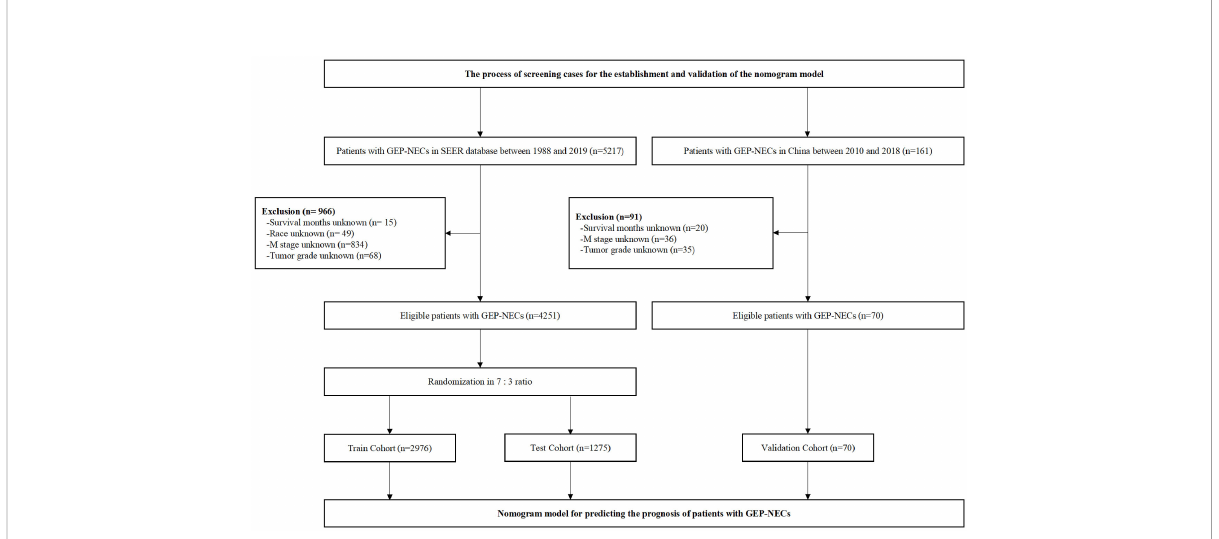
FIGURE 1 Flow chart of data fi ltering. SEER, Surveillance, Epidemiology, and End Results; GEP-NECs, gastroenteropancreatic neuroendocrine